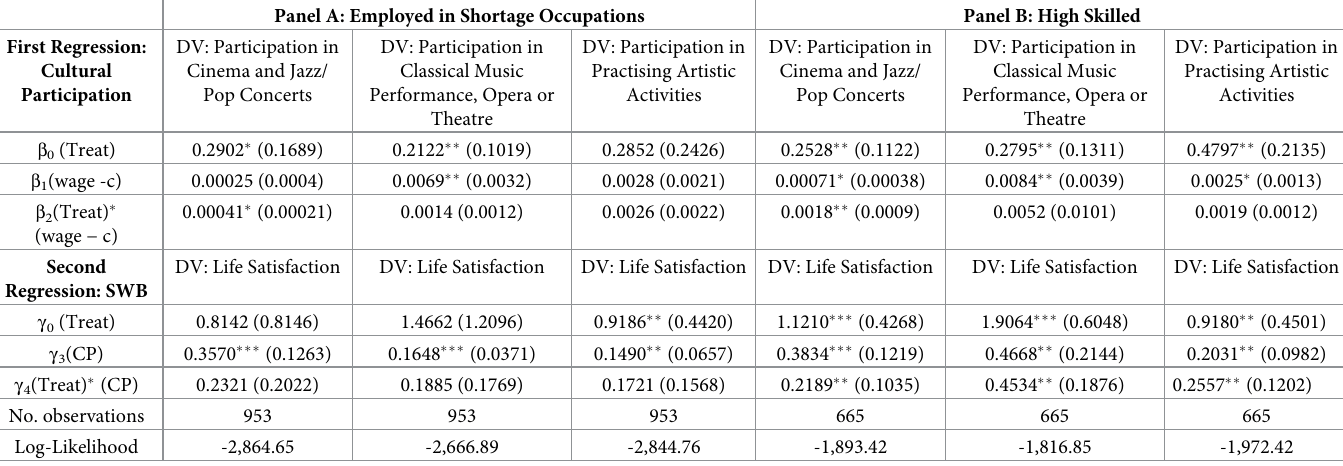
Table 7. RDD seemingly unrelated regression estimates for cultural participation and life satisfaction using a triangle Kernel and bandwidth of 4,000 €